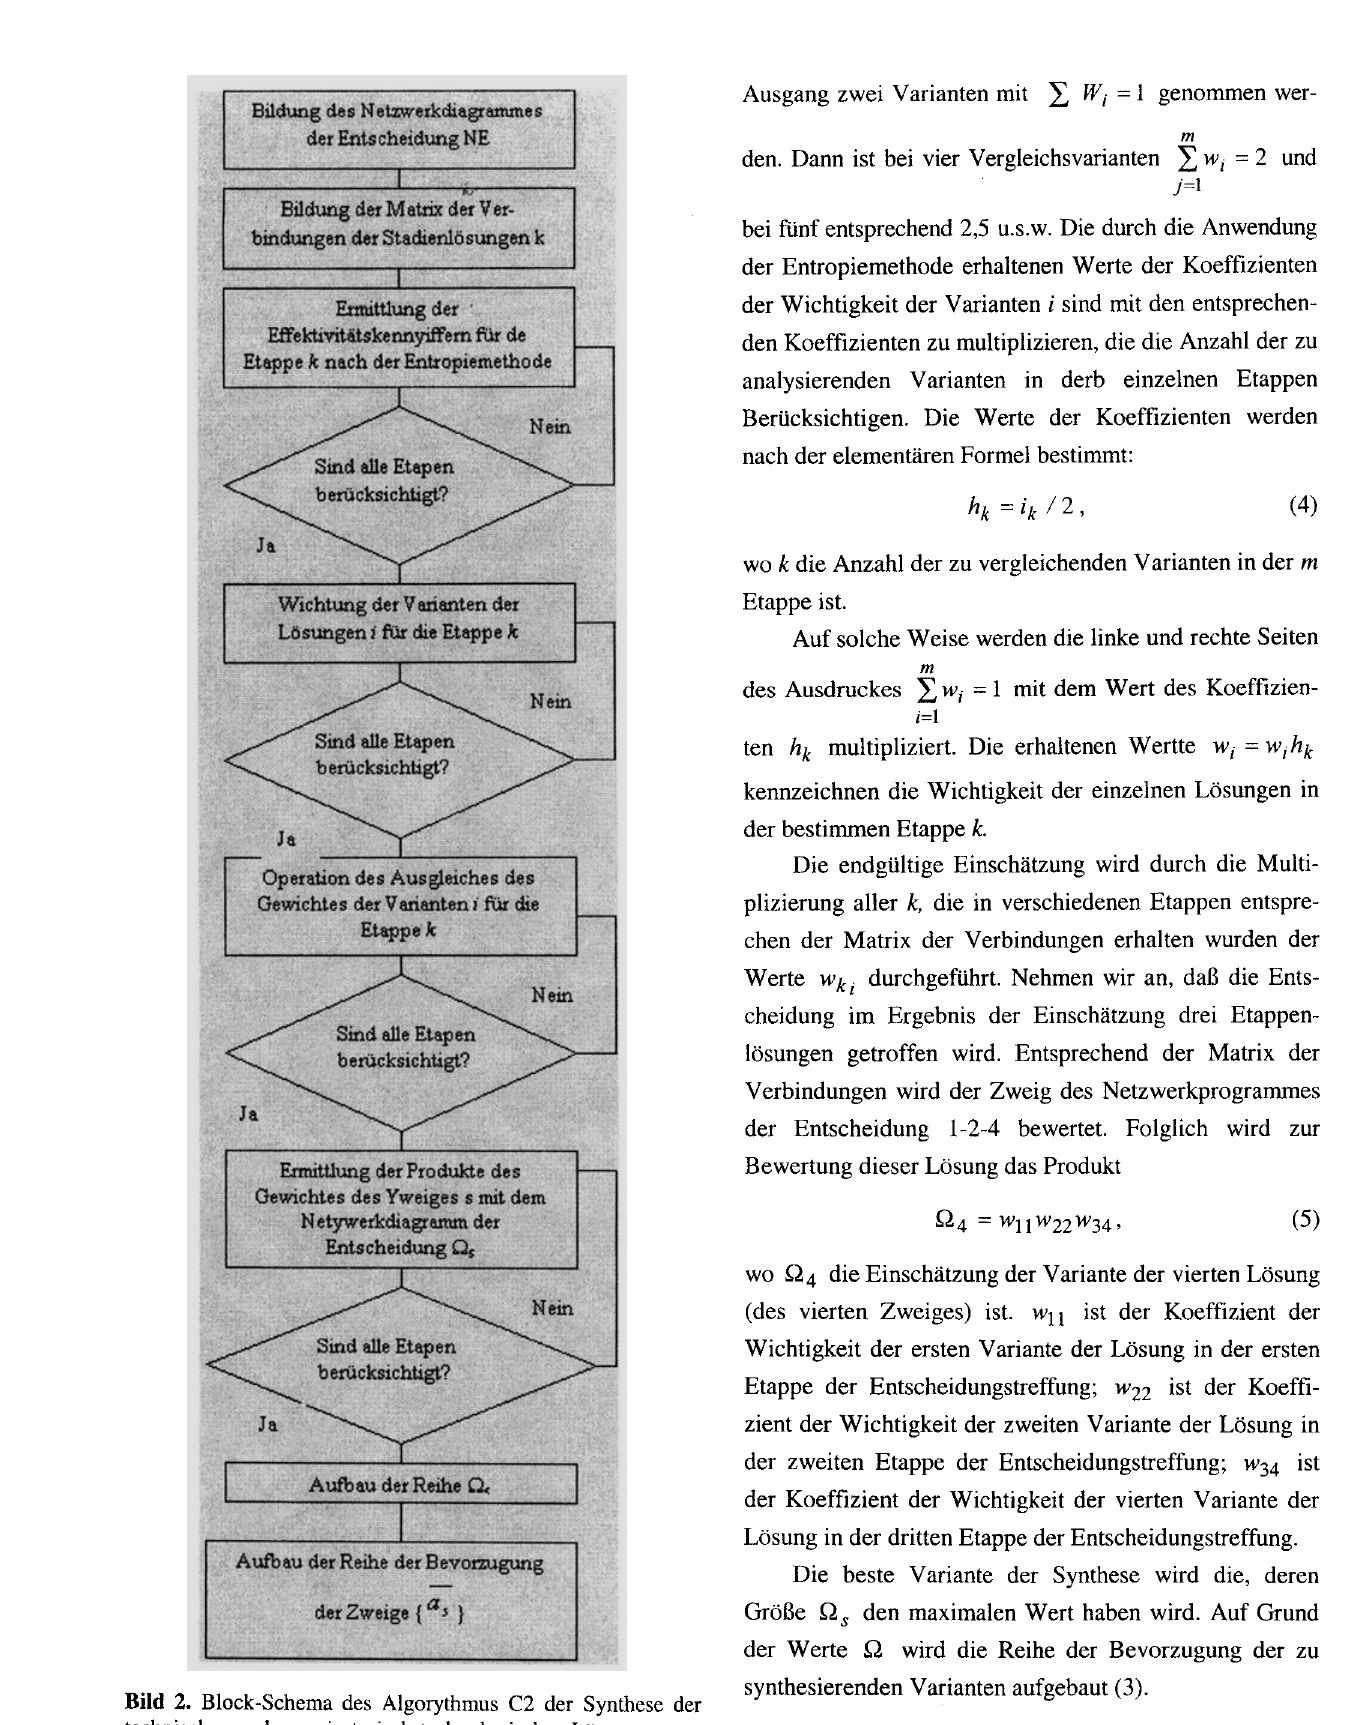
Fig 2. Scheme of algorithm C2 for technical and